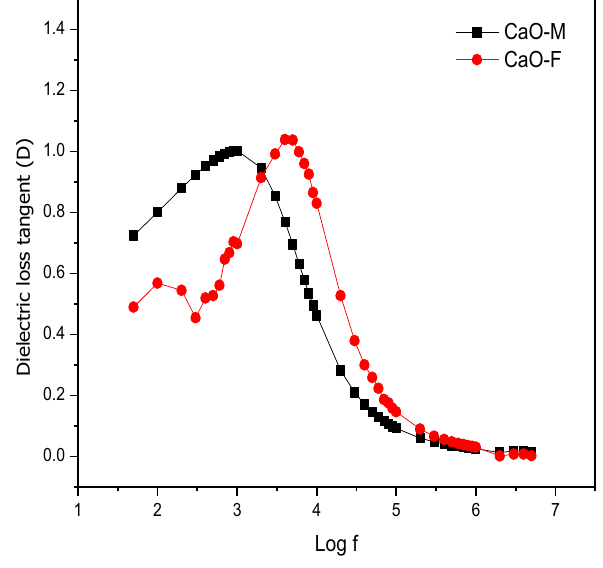
Fig. 8 Variation of dielectric loss tangent with frequency for CaO-M and